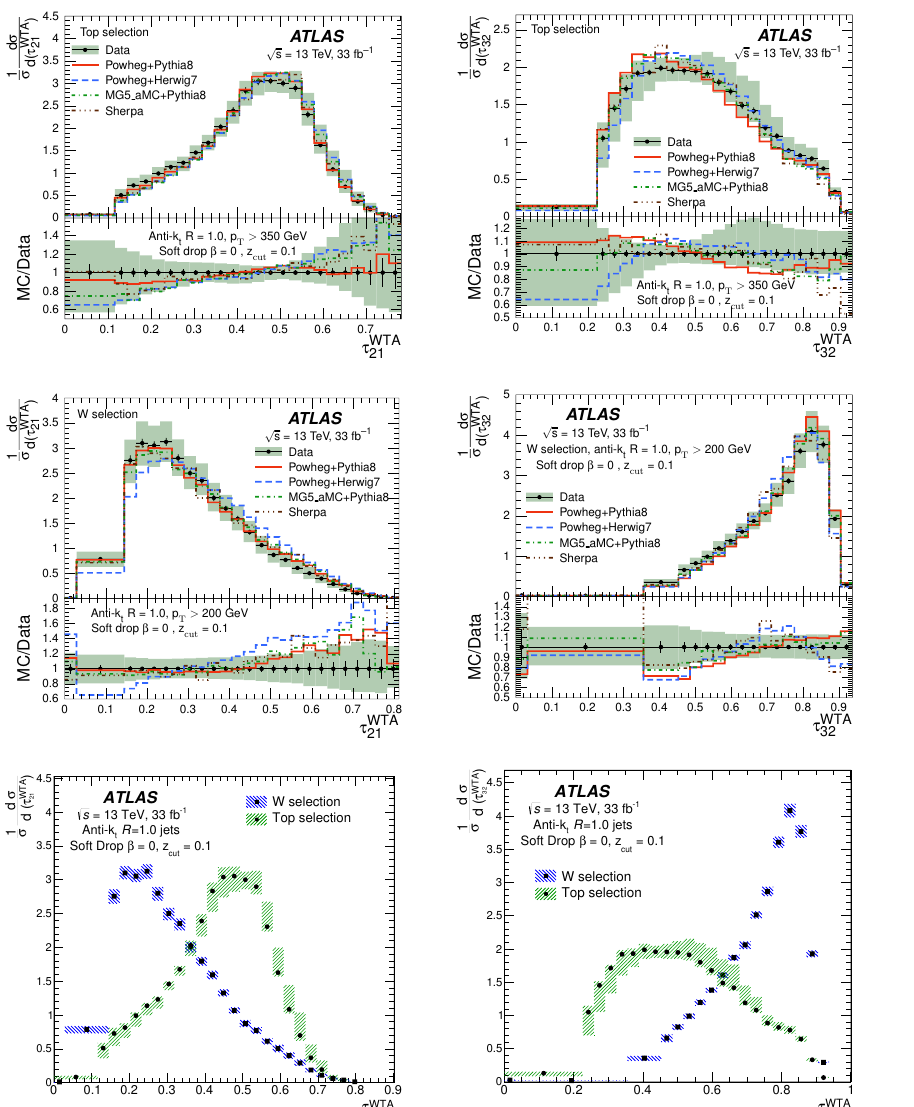
Figure 9 . The distributions of τ WTA (left) and τ WTA (right) are compared with different MC pre- 21 32 dictions for large-radius jets from top (top row) and W (bottom row) selections. The distributions of τ WTA (bottom left) and τ WTA (bottom right) in data are compared between the soft-dropped 21 32 large-radius jets for the two selections mentioned above. The subscript WTA indicates that WTA axis was used in calculating these observables. The shaded bands represent the total uncertainty, while the error bars show the statistical uncertainty, except in the bottom plots, where the shaded areas represent the total